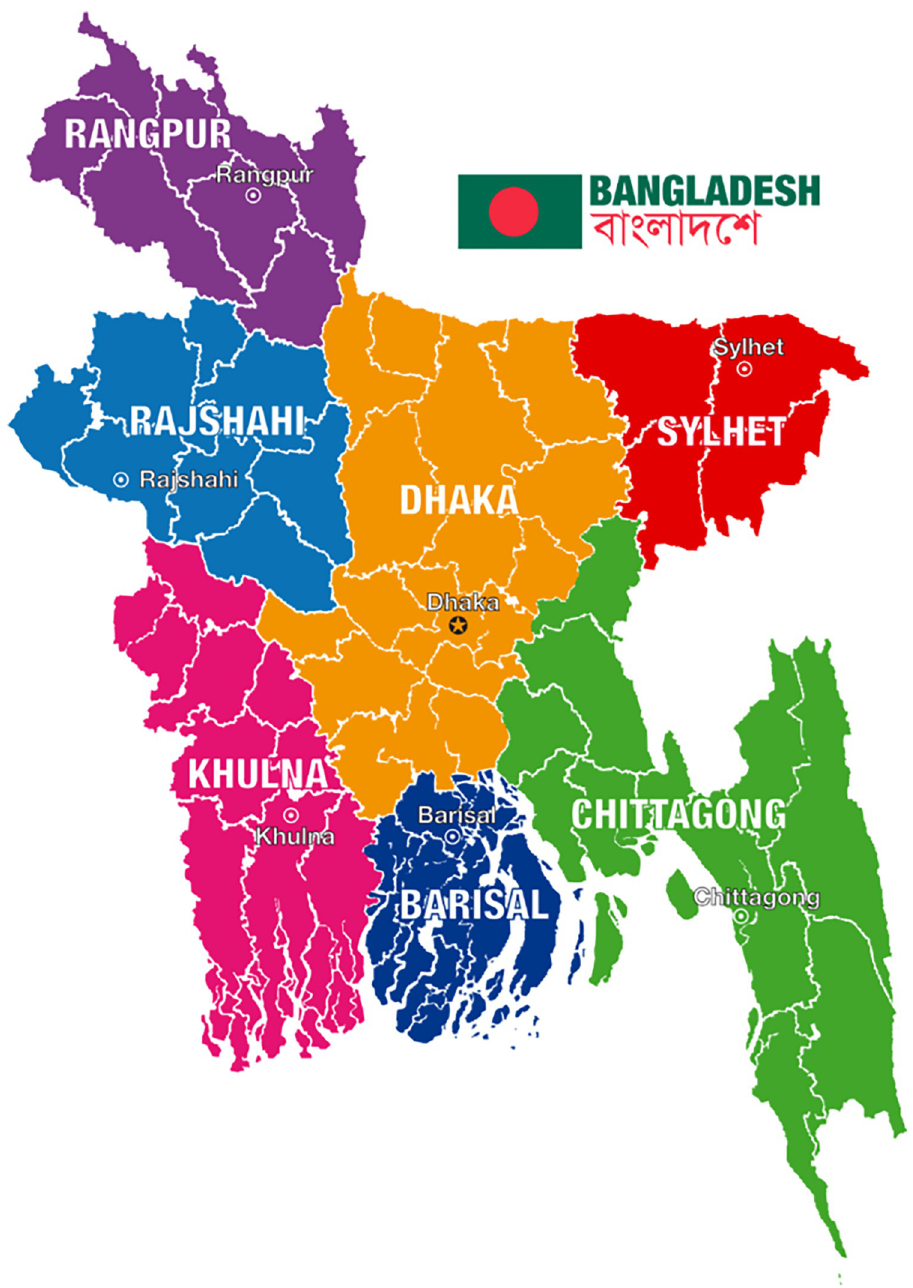
Fig 1. Political map of Bangladesh. Source: Bangladesh Political Map | Free